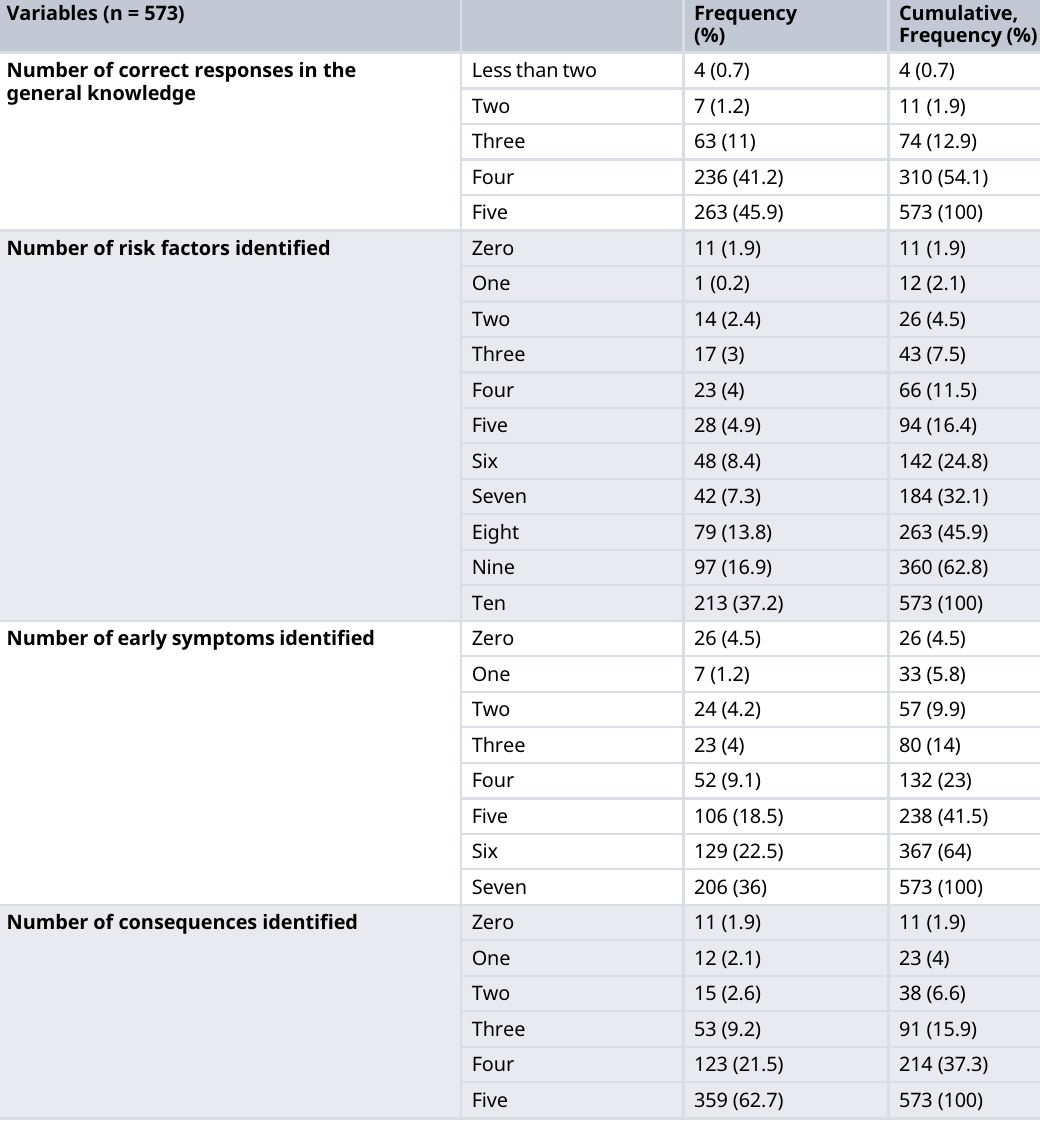
Table 2. Number of risk factors, early symptoms and consequences identified by the